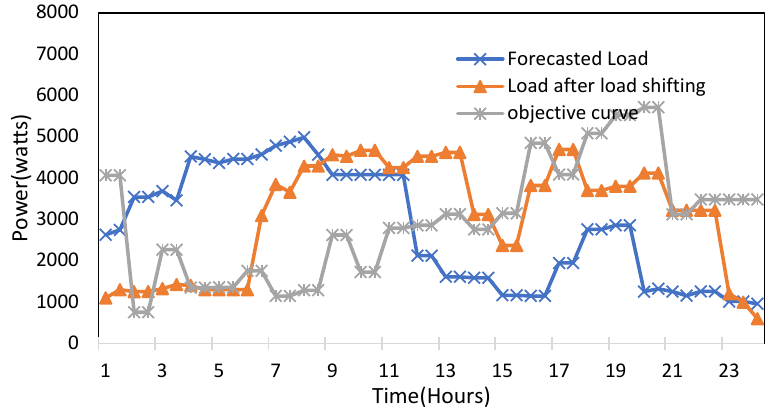
Figure 12. DSM results of commercial load under summer conditions.